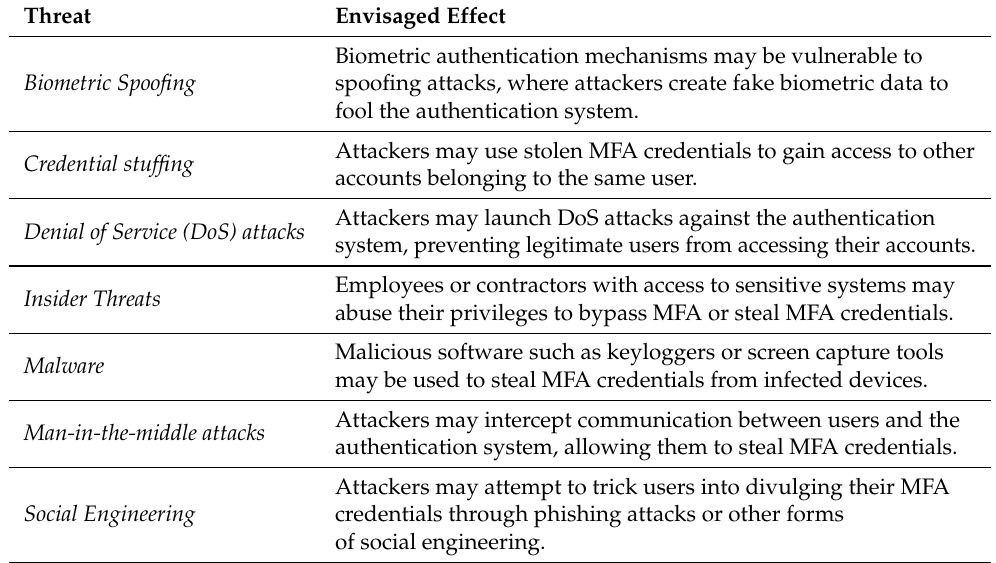
Table 5. Prominent Threats to MFA